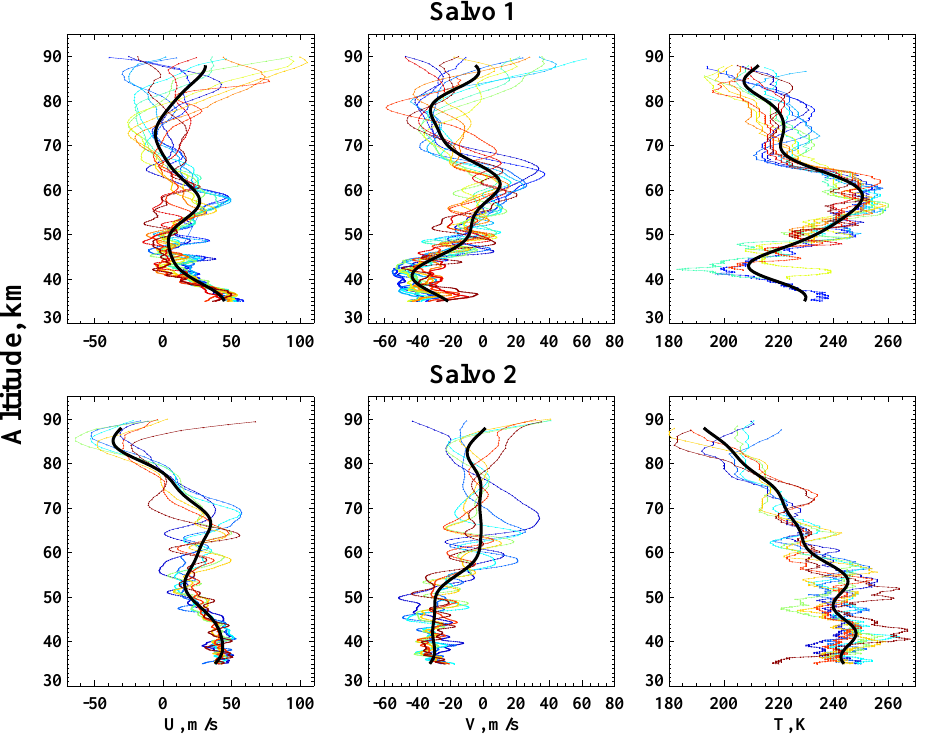
Fig. 4. Salvo mean winds and temperature (the thick dark lines) and the individual soundings within each salvo (the thin colored lines, with blue colors indicating earlier soundings and red colors indicating later